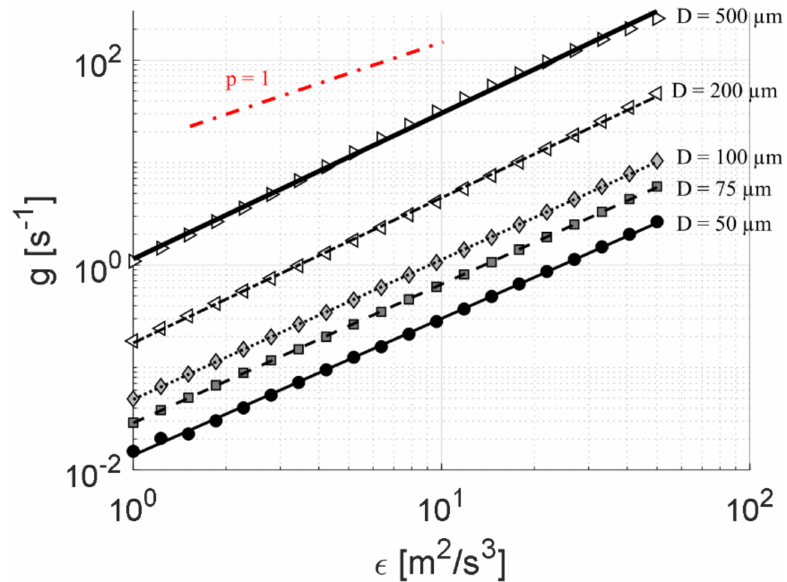
Figure 15. Scaling between local breakup frequency, g , and dissipation rate of TKE, ε , according to the model suggested by Lou and Svendsen for an oil-in-water emulsion ( ρ C = 10 3 kg/m 3 , µ C = 1 mPa s, γ = 20 mN/m) with drop diameters between 50 and 500 µ m. The dash-dotted red line shows the scaling g ~ ε p with p = 1 as a